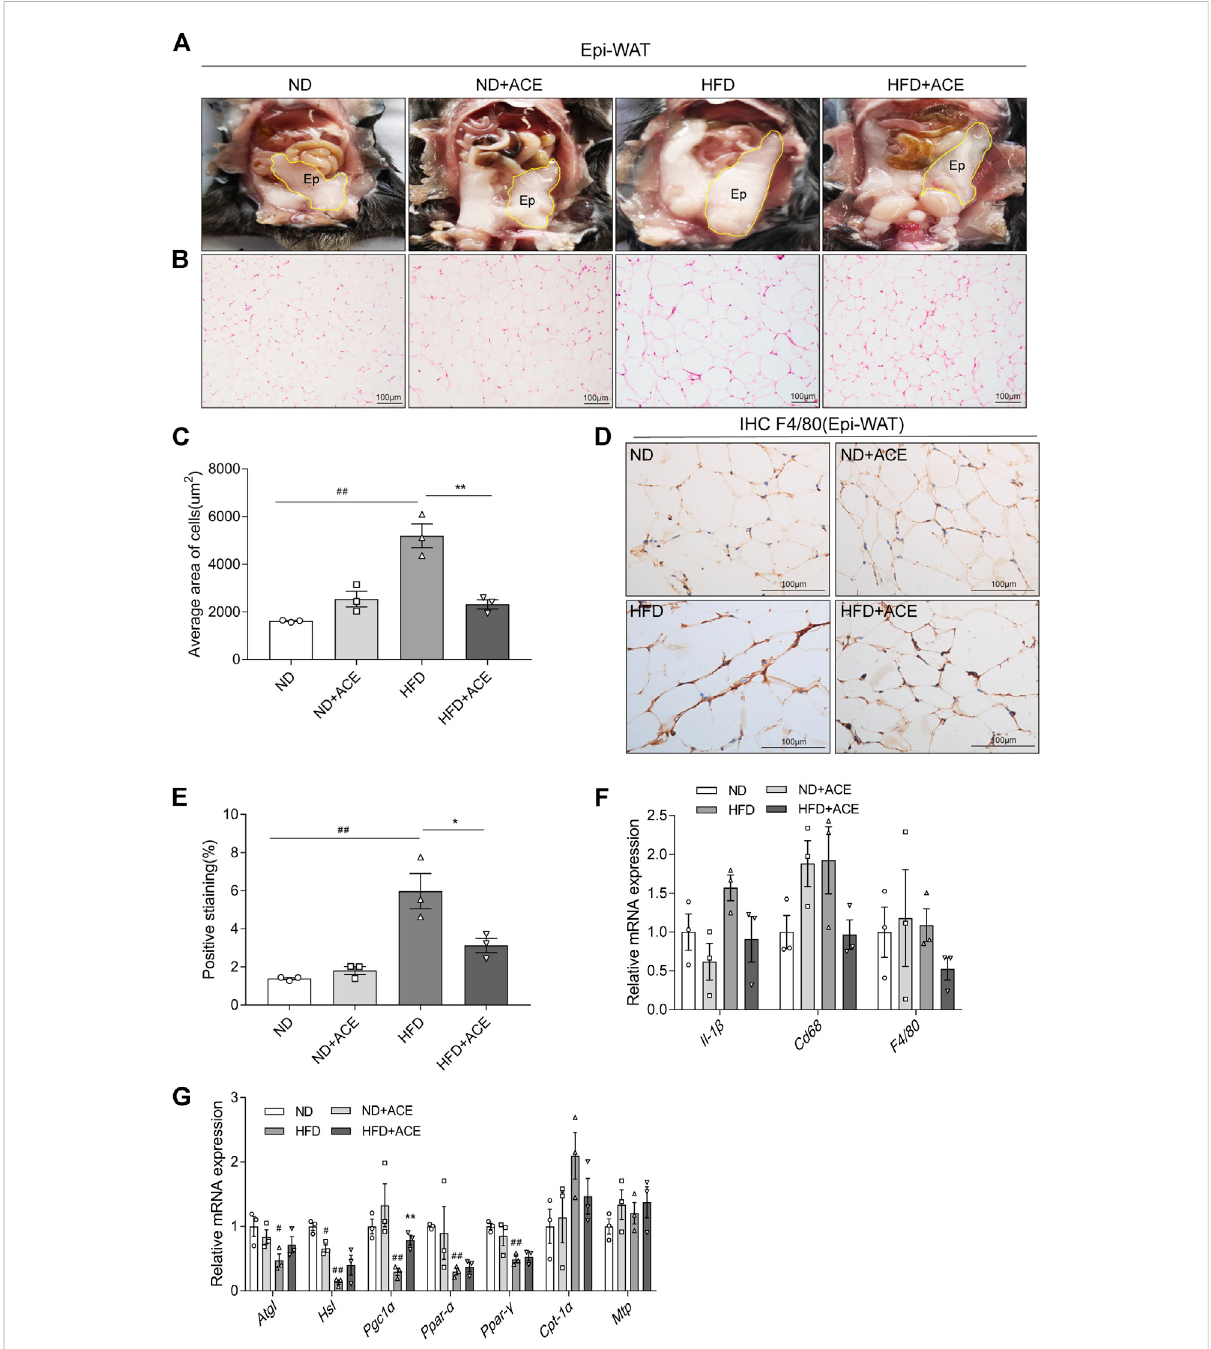
FIGURE 5 ACE ameliorated HFD-induced adipose tissue injury. (A) Representative pictures of dissected mouse abdomens with Epi-WAT highlighted in yellow. (B) Representative pictures of Hematoxylin and Eosin (H&E) staining for Epi-WAT tissue. Pictures were shown as 20 × zoom, scale: 100 μ m. (C) ThemeanAdipocytearea. (D) RepresentativepicturesofF4/80expressioninEpi-WATtissuesPictureswereshown as40×zoom,scale:100 μ m. (E) Quanti fi cation (% of positive stained area) of F4/80 in Epi-WAT tissues. (F) Relative expression of Il-1 β , Cd68 , F4/80 in adipose tissue. (G) Relative expression of Atgl , Hsl , Pgc1 α , Cpt-1 α , Mtp , Ppar- α , Ppar- γ in adipose tissue. Data were shown as means ± S.E.M (n = 3 per group). Statistical analysis was conducted by using an independent student- t test. # denotes p < 0.05 when compared with the ND group, ## denotes p < 0.01 when compared with the ND group; * denotes p < 0.05 when compared with the HFD group, ** denotes p < 0.01 when compared with the HFD